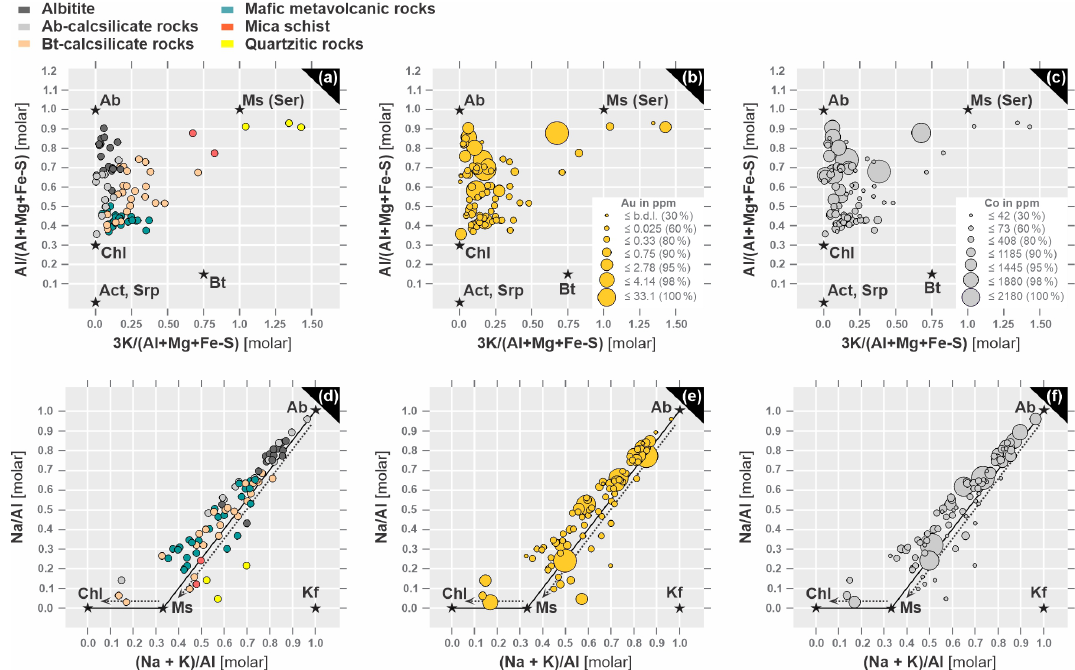
Figure 10. Graphical presentation of mass transfer processes at Raja in molar element ratio diagrams in correlation with Au and Co grades. Axes are molar ratios. Diagrams are taken from Stanley (2017). Molar ratio plots of 3K /( Al + Mg + ( Fe − S ) versus Al /( Al + Mg + Fe − S ) classified according to (a) lithologies, (b) Au concentrations (in ppm) and (c) Co concentrations (in ppm). General element ratio diagrams using ( Na + K )/ Al versus Na / Al and classified according to (d) lithologies, (e) Au concentrations (in ppm) and (f) Co concentrations (in ppm). Lithology and concentration legends from (a) , (b) and (c) are also used in (d) , (e) and (f) . Ab – albite, Act – actinolite, Bt –